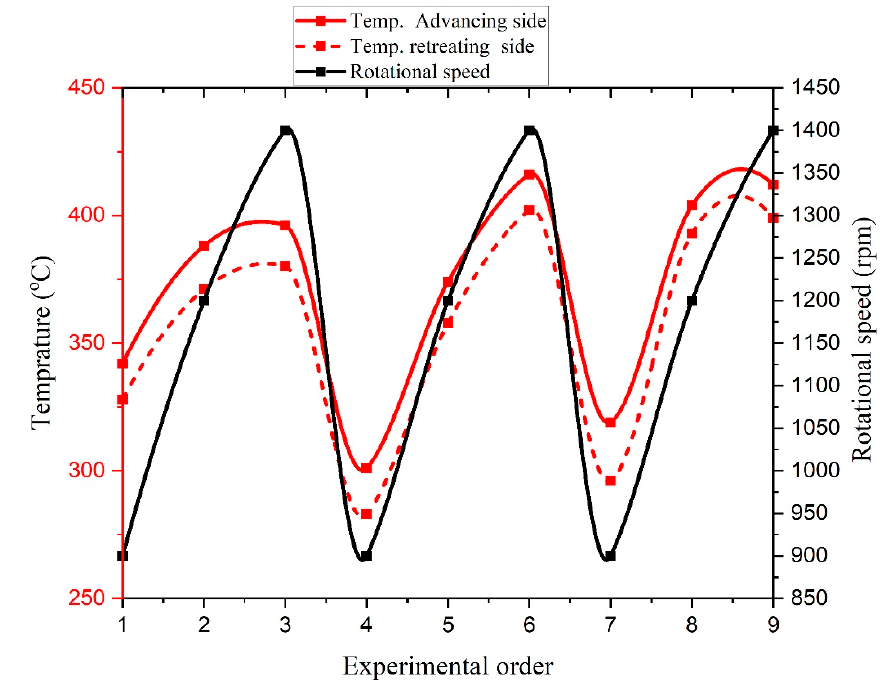
Figure 9. Correlation between rotational speed and welding temperature.